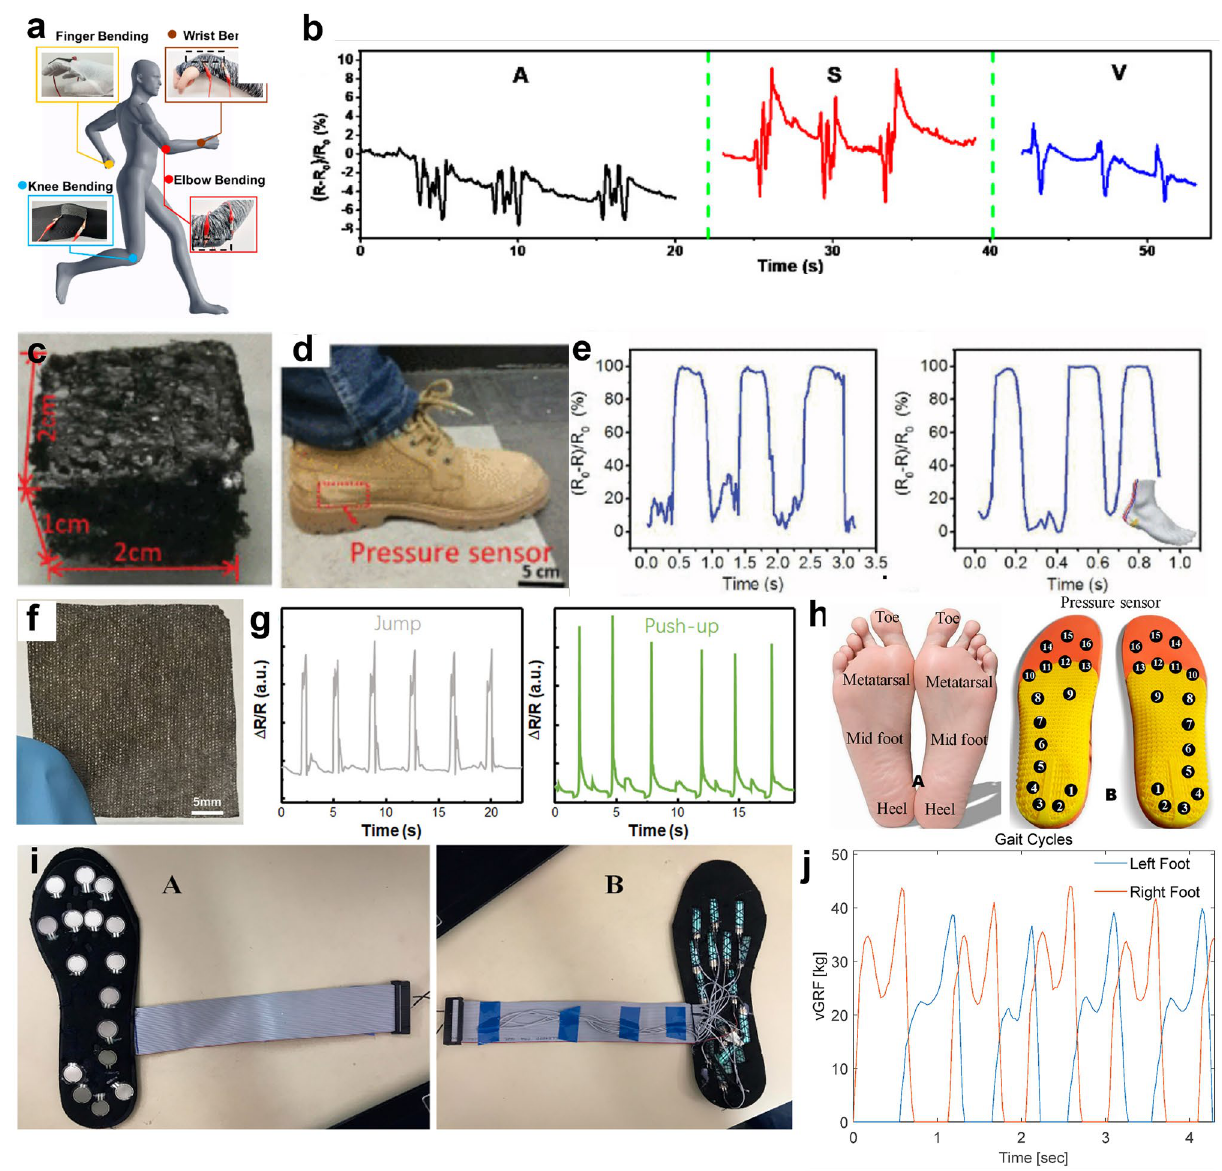
Fig. 9 Soft sensors for human motion. a Detection of various human motions using the wearable graphene textile strain sensor. b Detection of writing English letters. Reproduced with permission [103]. Copyright (2018), American Chemical Society. c Photograph of the honeycomb-like graphene composite structure. d Photograph of the foot with the HGN pressure sensor. e Response of the HGN pressure sensor under walking and running. Reproduced with permission [248]. Copyright (2020), Institute of Electrical and Electronics Engineers. f Tissue paper with rGO. g Response curves for the tester’s movements of jumping and push-ups. Reproduced with permission [102]. Copyright (2017), American Chemi- cal Society. h Area of foot selected for sensors and i array of pressure sensor. j Gait cycles readings for left and right foot with FSR smart insole. Reproduced with permission [249]. Copyright (2020),